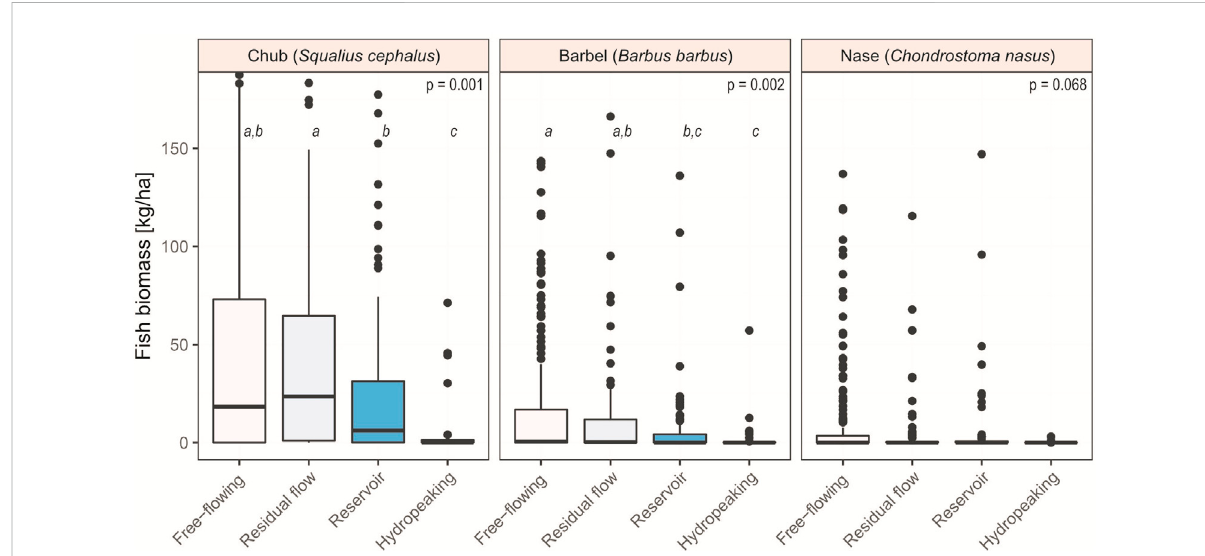
FIGURE 3 Biomass of the three target species in different hydro-morphological types. Grand median: Chub = 14.3 kg/ha, barbel = 0.02 kg/ha, nase = 0.0 kg/ha. Outliers > 180 kg/ha have been graphically cut off for better readability (chub: n= 55, max = 1,107 kg/ha; barbel: n= 10, max = 682 kg/ha; nase: n = 9, max = 1,076 kg/ha). This dataset includes only river sections where the respective target species is classi fi ed as ‘ dominant ’ or ‘ subdominant ’ accordingtotheAustrianLeitbildclassi fi cation(BAW,2007).Thesamelettersabovetheboxplotsindicatethatthecategories are considered equal, different letters indicate a signi fi cant